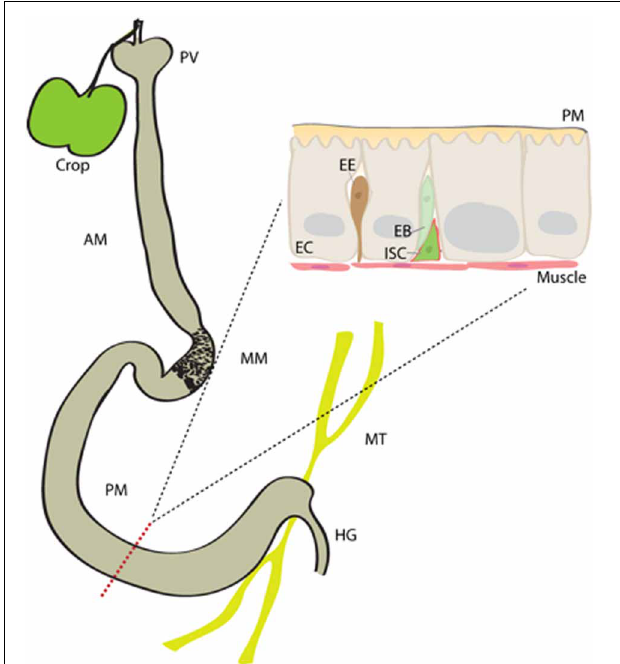
FIGURE 1 | The Drosophila intestine . The midgut in Drosophila is subdivided into anterior midgut (AM), middle midgut (MM) and posterior midgut (PM) regions. It contains single population of mitotically active intestinal stem cells (ISCs), which spread throughout from anterior to posterior regions. An ISC asymmetrically divides to generate an intermediate enteroblast (EB), which eventually differentiates either into an enterocyte (EC) or enteroendocrine (EE) cell. proventriculous (PV), hindgut (HG), Malpighian tubules (MT), peritrophic matrix